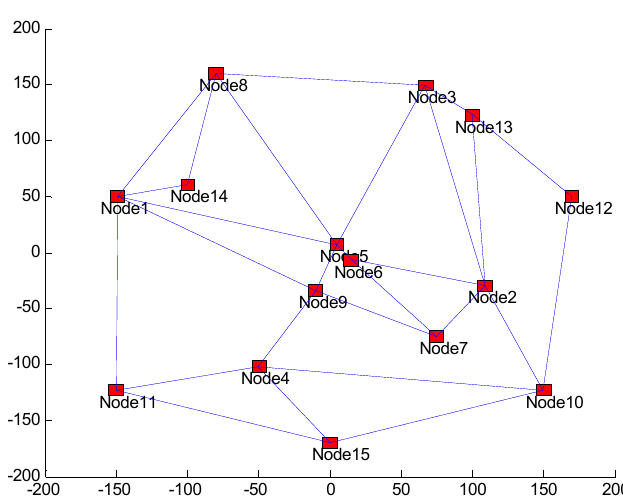
Figure 4. Graph with CONFIG 15-1 configuration (15 nodes).